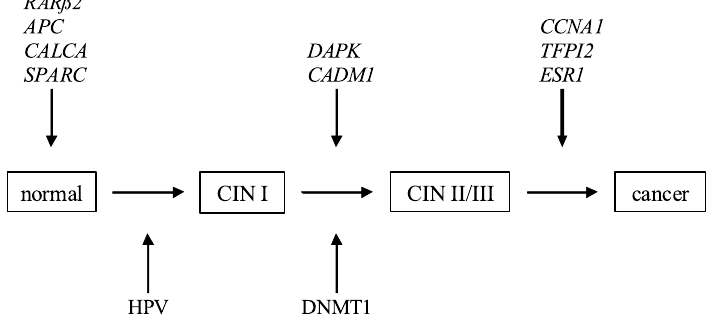
Fig. 3. Schematic model of the course of DNA promoter methylation in cervical carcinogenesis. The amount of dysplastic cells are depicted in gray. The arrows indicate at which stage of cervical carcinogenesis the gene promoters became mainly methylated or transfection with